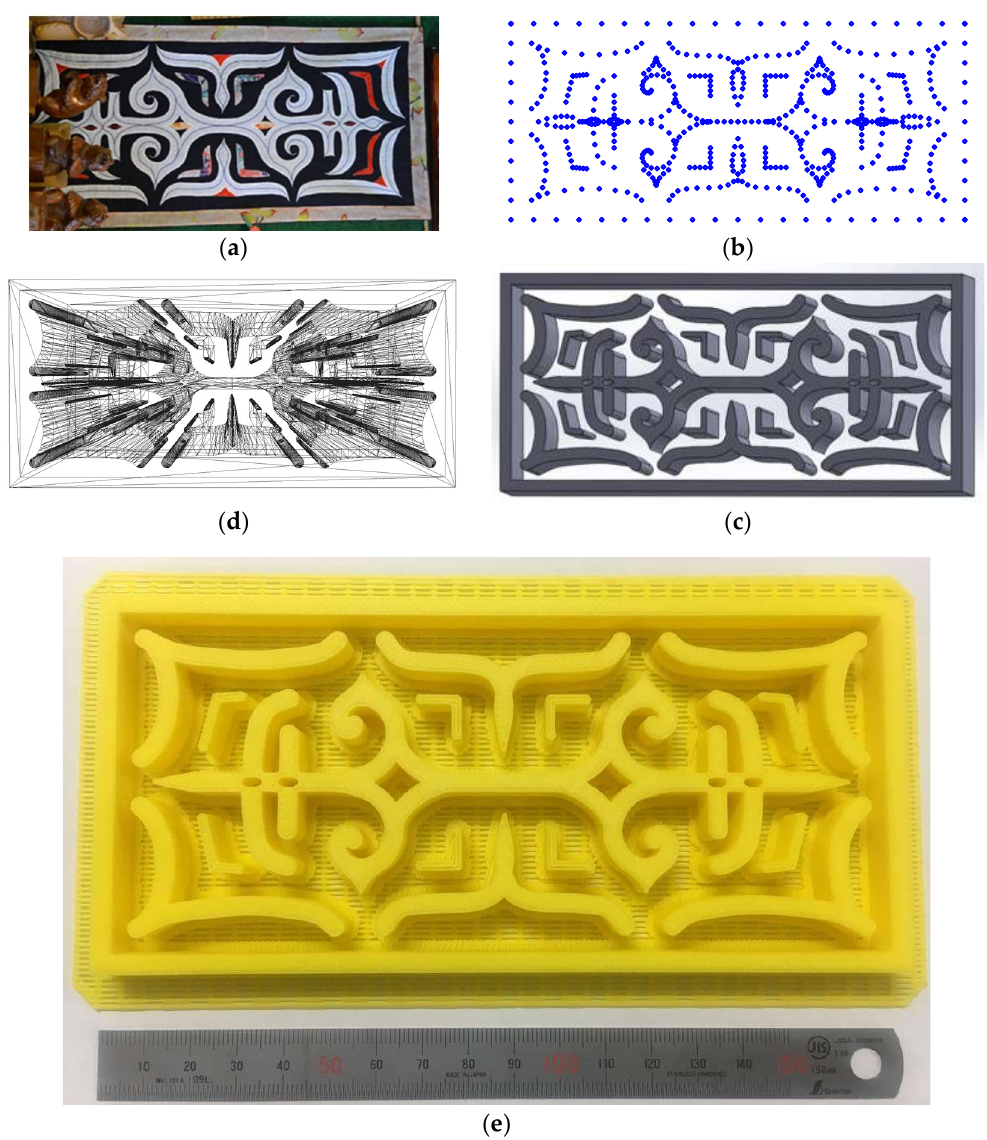
Figure 14. Model-3 based on Ainu motifs. ( a ) Ainu Motif; ( b ) Point-cloud; ( c ) Solid CAD Model; ( d ) Triangulation data; ( e ) Physical model built by 3D printing.